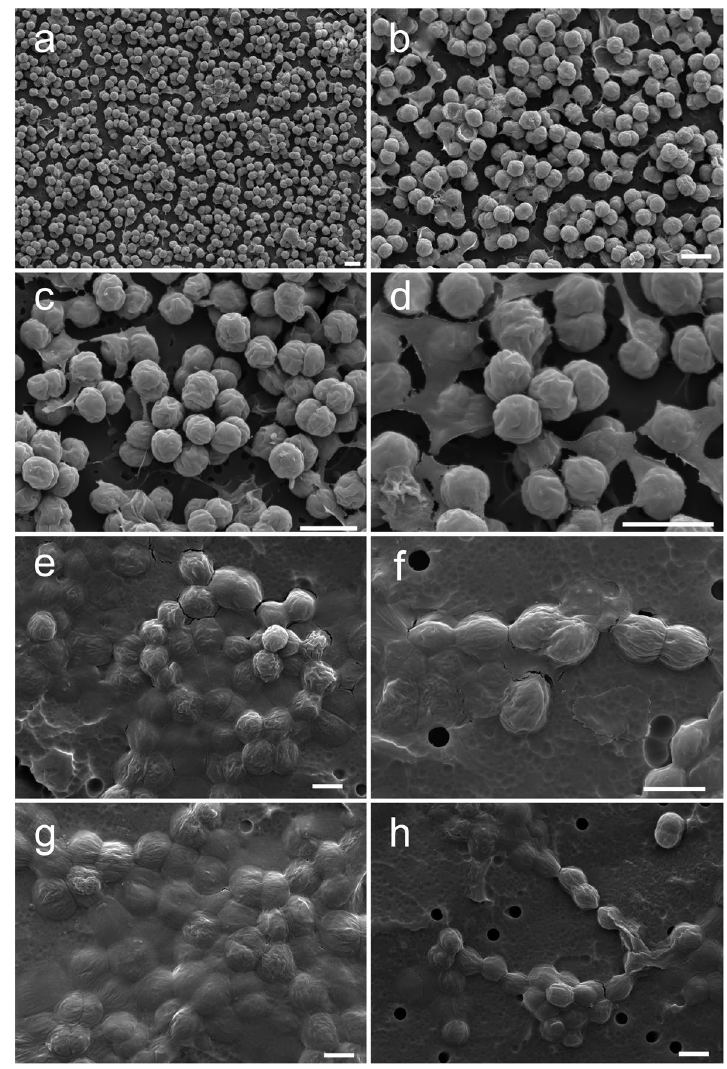
Fig. 5 Scanning electron microscopy (SEM) images of Microcystis aeruginosa . a – d colony of M. aeruginosa , e – h resting cells of M. aerginosa. Scale bar 5 =